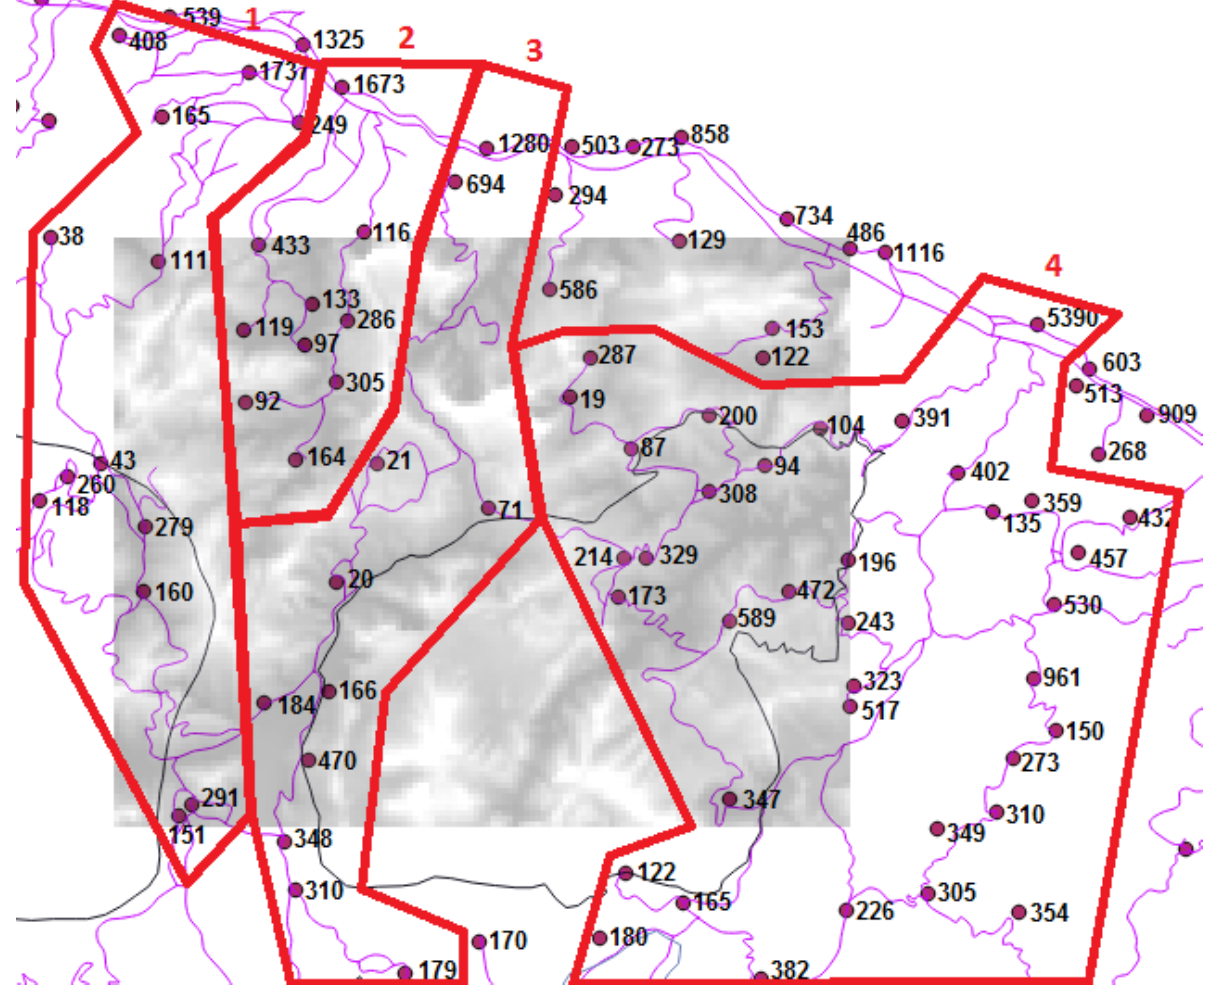
Figure 5. A population map of the area and road